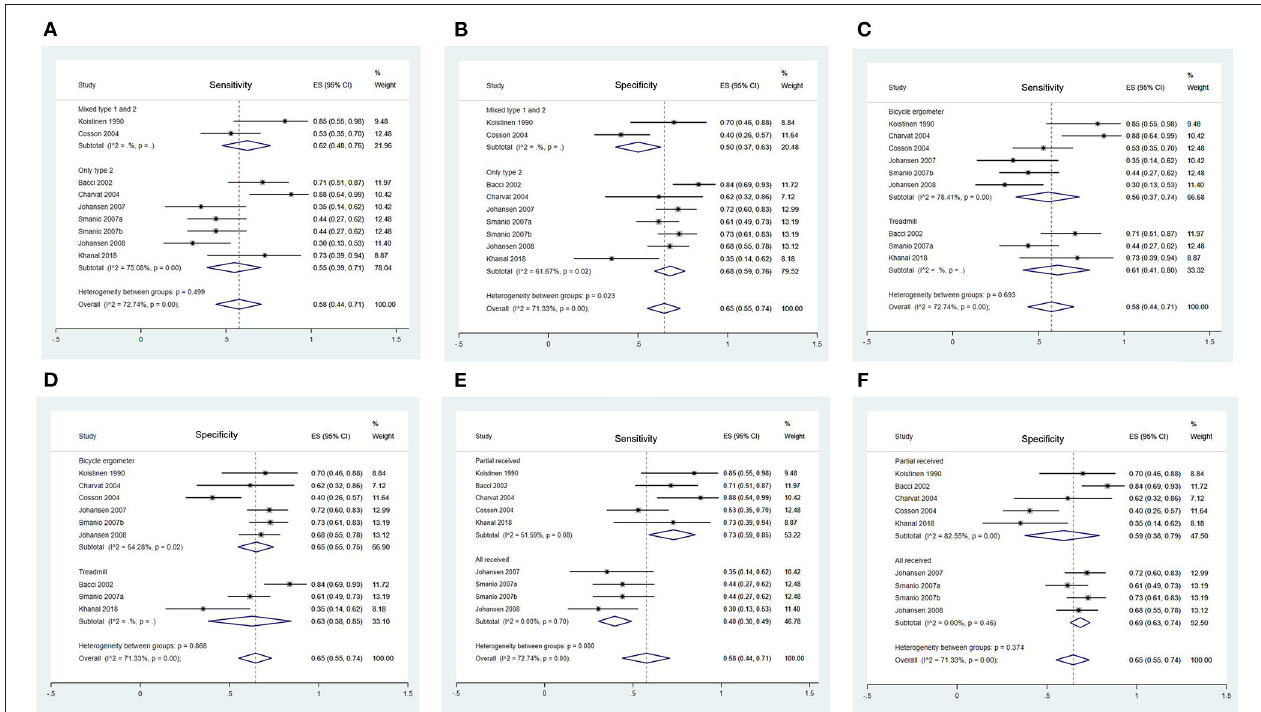
FIGURE 2 | Forest Plots of Sensitivity and Specificity of EST in Different Subgroups. (A) Forest plot of sensitivity of EST in different type of diabetes; (B) Forest plot of specificity of EST in different type of diabetes; (C) Forest plot of sensitivity of EST in different exercise protocol; (D) Forest plot of specificity of EST in different exercise protocol; (E) Forest plot of sensitivity of EST in different proportion of included participants; (F) Forest plot of specificity of EST in different proportion of included